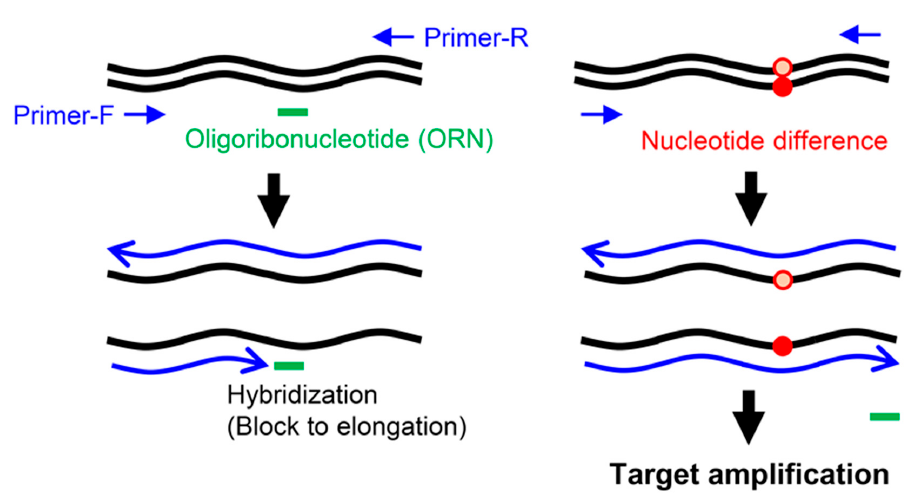
Figure 1. Schematic diagram of ORNi-PCR. In ORNi-PCR, an ORN hybridized with a target site blocks elongation (blue lines) of a DNA polymerase that does not possess 5 ′ to 3 ′ exonuclease activity. If the target site is mutated (red dots), the ORN cannot effectively hybridize to the target site, resulting in target amplification.